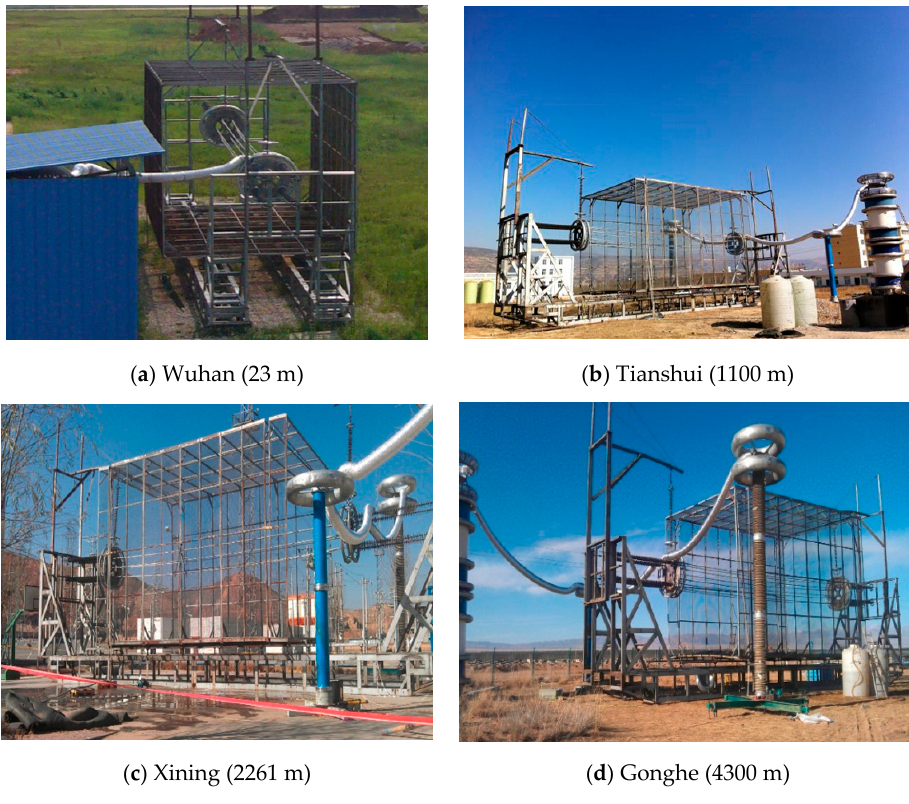
Figure 3. AC corona cage tests at different altitudes.